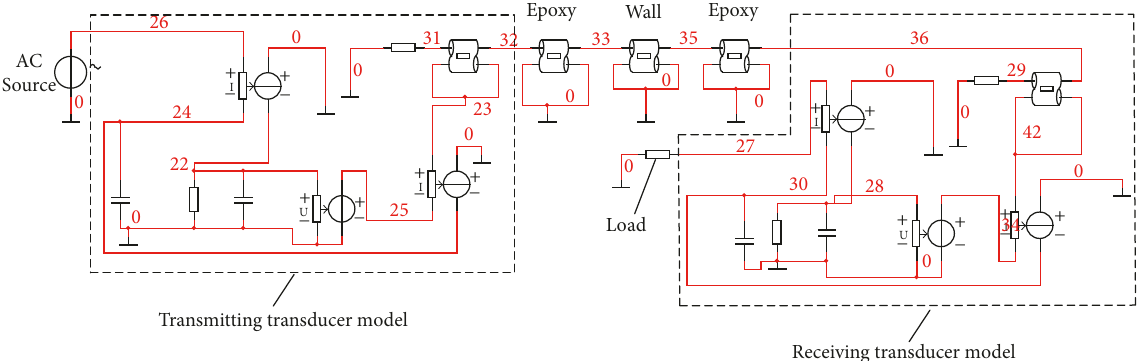
Figure 4: Leach’s equivalent circuit model of the ultrasonic vibration transmission channel through a planar metal barrier.